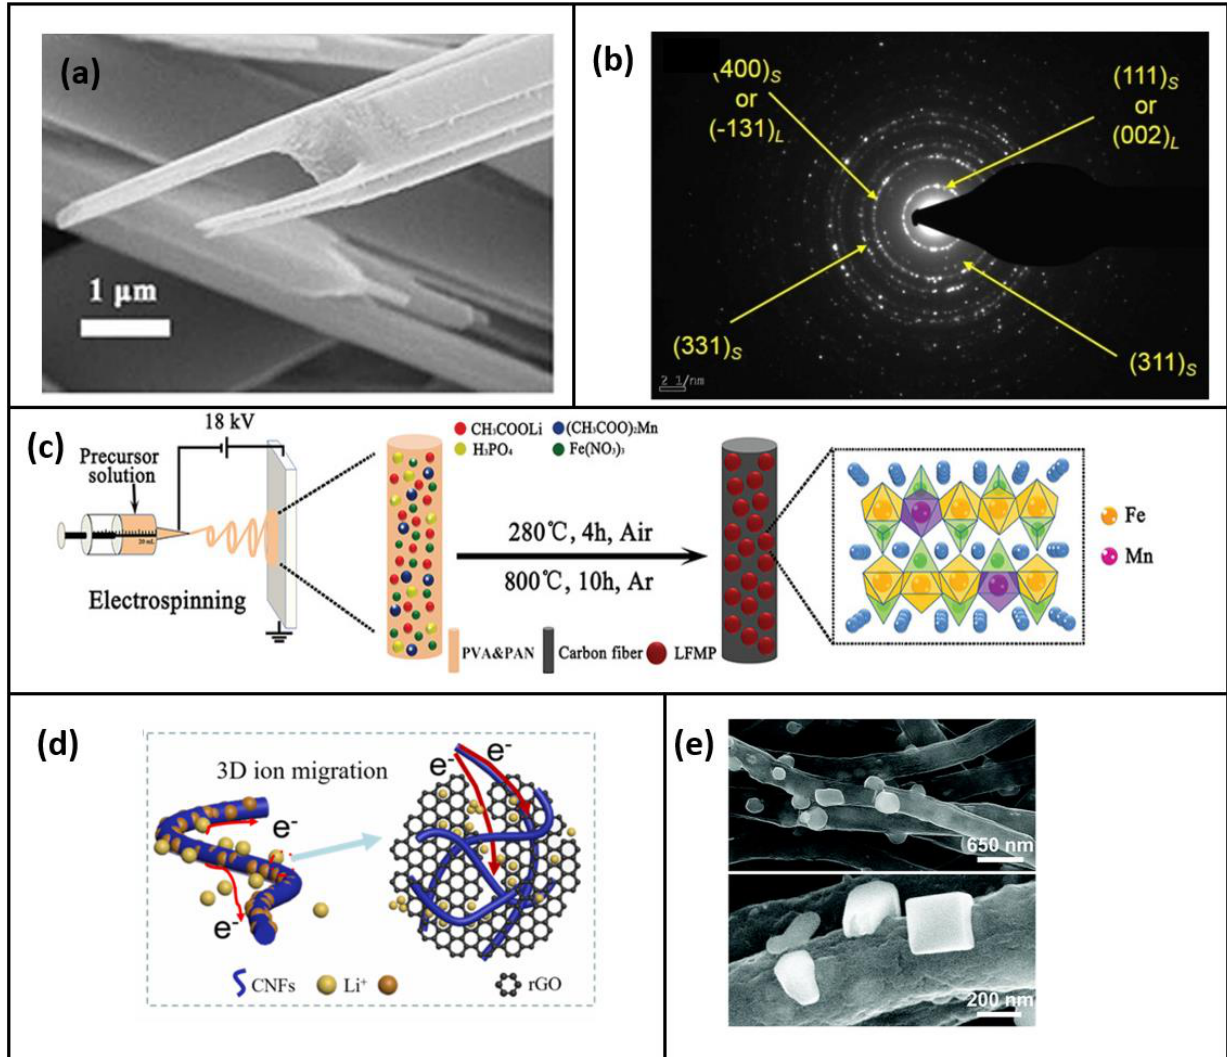
Figure 3. ( a ) TEM image of electro-spun fork-like K 2 V 8 O 21 (Reprinted with permission from Ref. [25] 2018, Frontiers) ( b ) SAED patterns of the nanofiber showing the spinel (S) and layered (L) phase of LiM 2 O 4 (Reprinted with permission from Ref. [42] 2020, Elsevier) ( c ) Schematic of synthesis of the LFMP/C nanofibers ( d ) Diagram showing r GO improving material conductivity and ion diffusion rate (Reprinted with permission from Ref. [47] 2023, Elsevier) ( e ) High-magnification SEM images showing the cubic LVP nanoparticles embedded in the CNF networks (Reprinted with permission from Ref. [52] 2019, RSC).